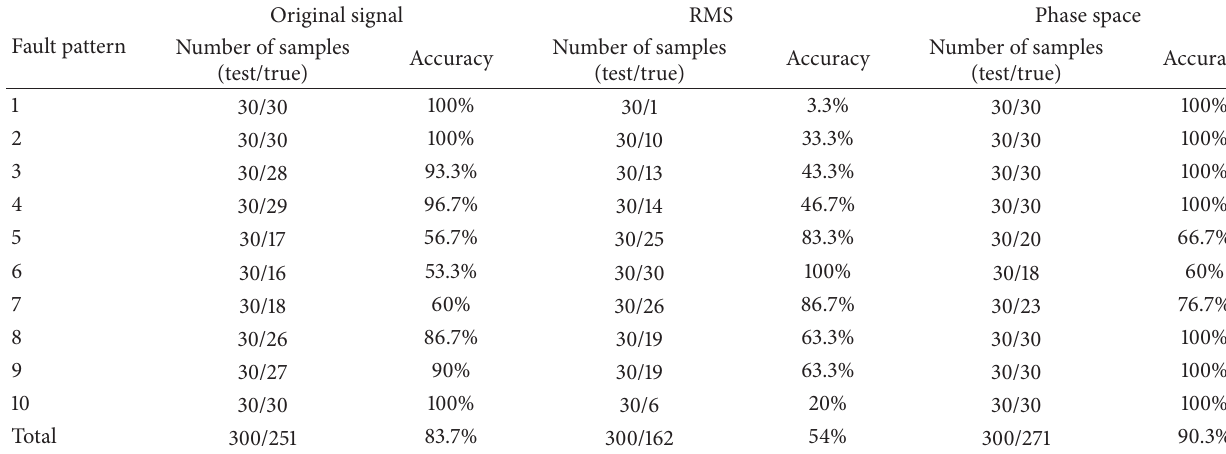
feature RMS is selected as input. The results are shown in Table